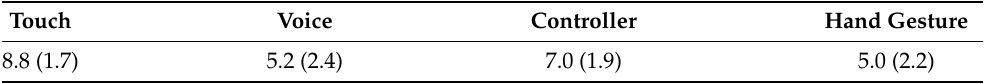
Table 4. Mean ( SD ) rating of ease a of use for the four methods of interacting with smart devices. Touch